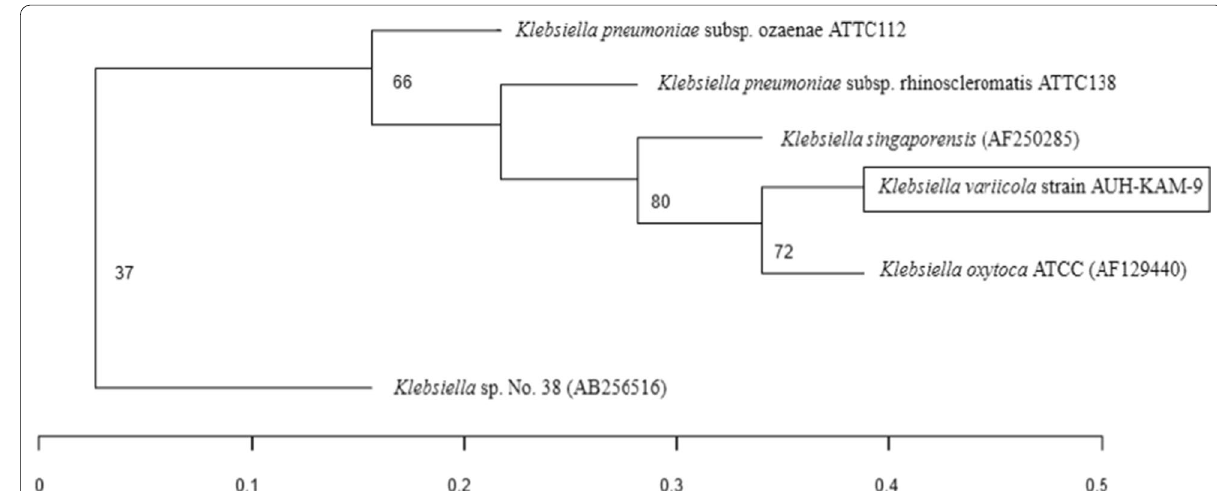
Fig. 16 Phylogenetic tree showing the relationships between the phosphate-solubilizing bacteria (PSB) isolates in this study and their closest phylogenetic relatives based on 16S rRNA gene sequencing. Isolate with rectangle was identified in this study.